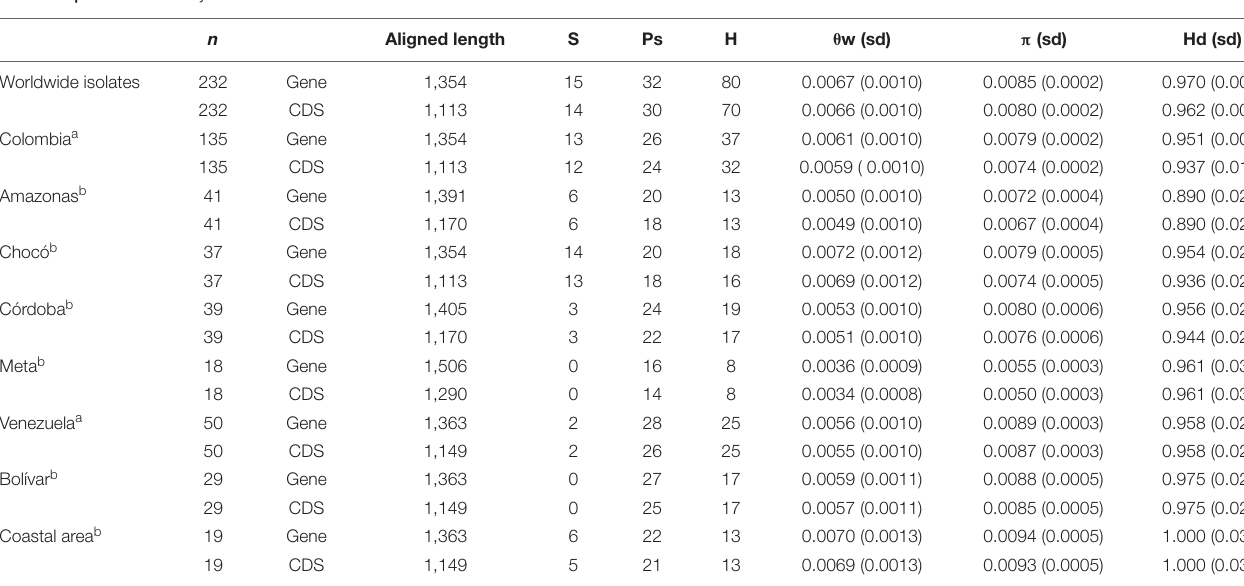
FIGURE 1 | Phylogenetic tree mapping the presence/absence of rbsa locus and duplication events. The phylogenetic tree represents Plasmodium evolutionary history. The branches are colored regarding their vertebrate host. The rbsa locus was found in parasites from monkey-malaria clade, but it was not clear whether the rbsa gene became lost from the other clades or arose exclusively in the monkey-malaria clade. rbsa became lost in P. knowlesi and P. coatneyi whilst duplication events occurred in P. vivax and P. cynomolgi . Models of putative ancestral chromosome 3 are displayed, indicating the arrangement after the duplication event (chr derived). PlasmoDB genome fragment annotation is also shown. P. cynomolgi rbsa ( pcrbsa ) and its paralog ( pcrbsap ) had a premature stop codon regarding P. vivax rbsa sequences, indicated by a white rectangle in the pcrbsa and pcrbsap gene models. TABLE 1 | Genetic diversity